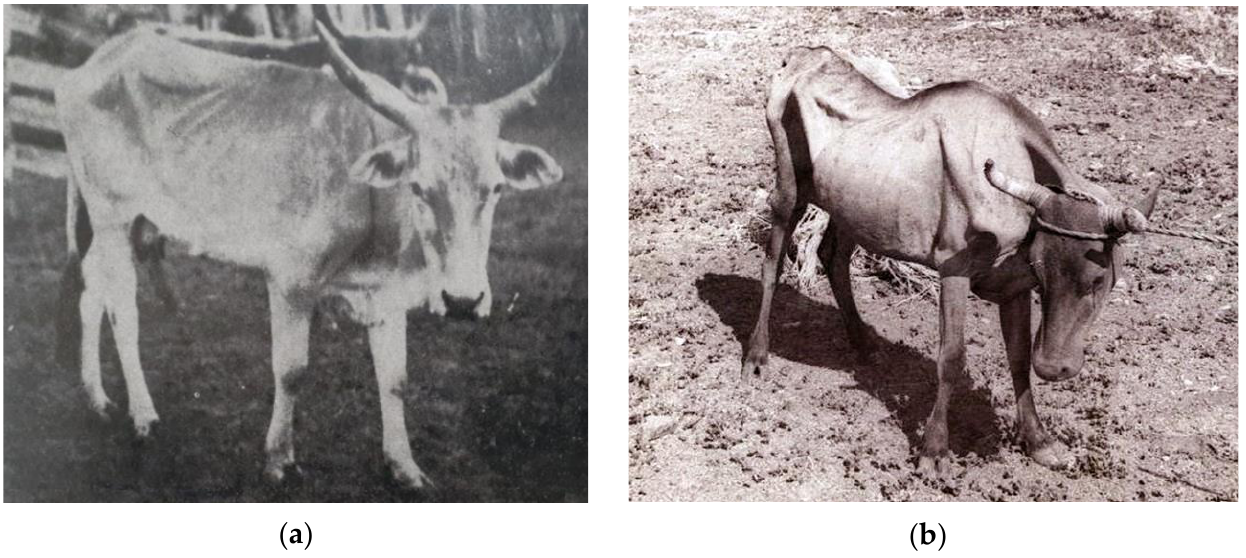
Figure 1. ( a ) Lean, dry cow that had failed calving for over two years and was reluctant to move when the photo was taken in Par á de Minas, MG, Brazil [17]. ( b ) Cow showing severe lordosis and hock deviations due to clinical P deficiency, photo taken in 1956, Altos, PI, Brazil